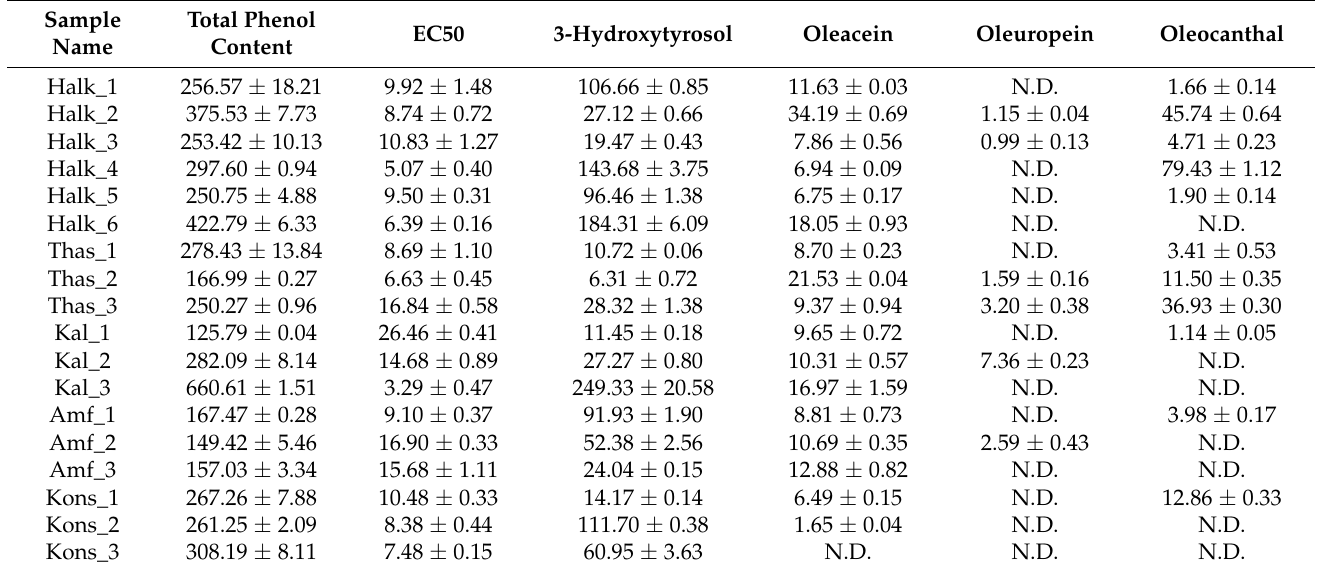
Table 4. Biochemical values of the 18 samples analyzed. The results are expressed as mean ± standard deviation ( n = 3). Units of measurement for total phenol content is mg of caffeic acid/100 g of dry olives, while for 3-hydroxytyrosol, oleacein, oleuropein, and oleocanthal it is mg/100 g of dry olives. N.D., not detected.